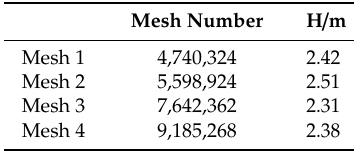
Table 2. Mesh independence